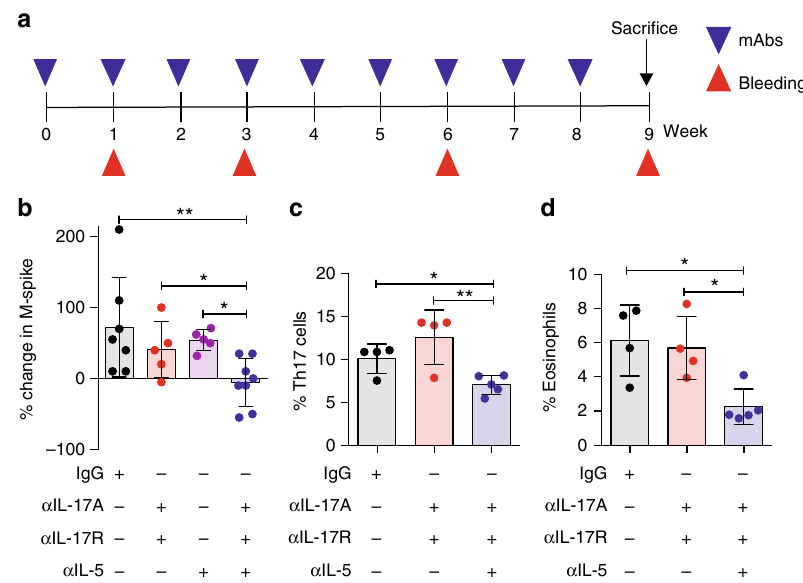
Fig. 6 IL-17-eosinophil axis neutralization delays disease progression in Vk*MYC mice. a Schematic representation of the experiment. b Percentage change in M-spike in mice within the indicated cohort (Isotype and α IL-17A, α IL-17R, α IL-5: n = 8 mice/group, α IL-17A, α IL-17R and α IL-5: n = 5 mice/group) during the observation period. Frequency of BM Th17 (i.e., CD3 + CD4 + IL-17 + ) cells c and eosinophils (i.e., CD11b + Ly6C int MHC-II − Ly6G − SSC hi d ) was assessed by fl ow cytometry. Each dot represents an individual mouse. c Mean ± SD of two independent experiment. (Isotype n = 4, α IL-17A, α IL-17R n = 4, α IL-17A, α IL-17R, α IL-5 n = 5). Unpaired t test: * P < 0.05; ** P < 0.01. d Mean ± SD of two independent experiment. (Isotype n = 4, α IL-17A, α IL-17R n = 4, α IL-17A, α IL-17R, α IL-5 n = 5). One-way ANOVA P =